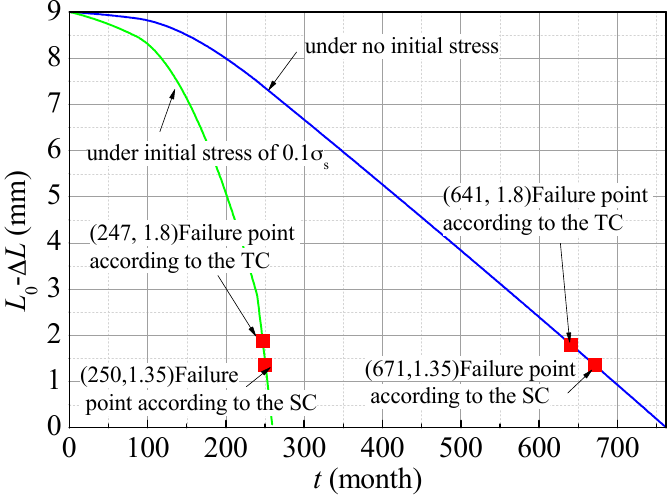
Figure 12. Variation of residual wall thickness of L80 steel with service time under different initial stress: 0 and 0.1 σ s , respectively.